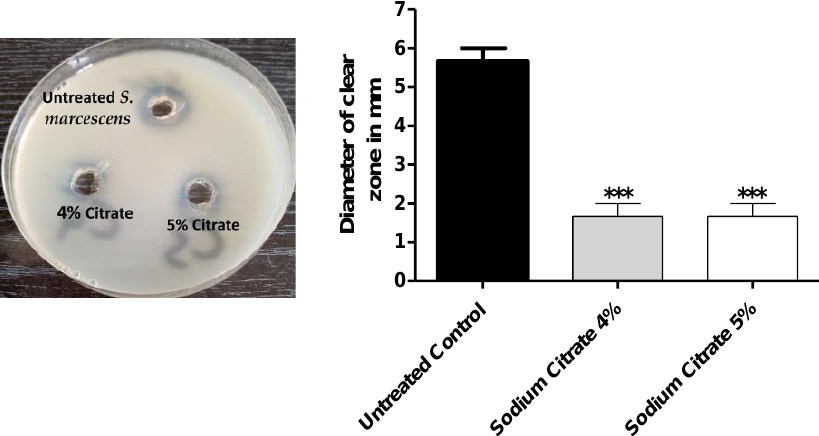
Figure 4. The effect of sodium citrate at 4% or 5% on the protease production. Citrate at 4% or 5% significantly decreased the clear zones around the wells loaded with extracellular protease (60%), indicating decrease in protease production. The One-way ANOVA test was employed to assess significance; ***: p ≤ 0.001.